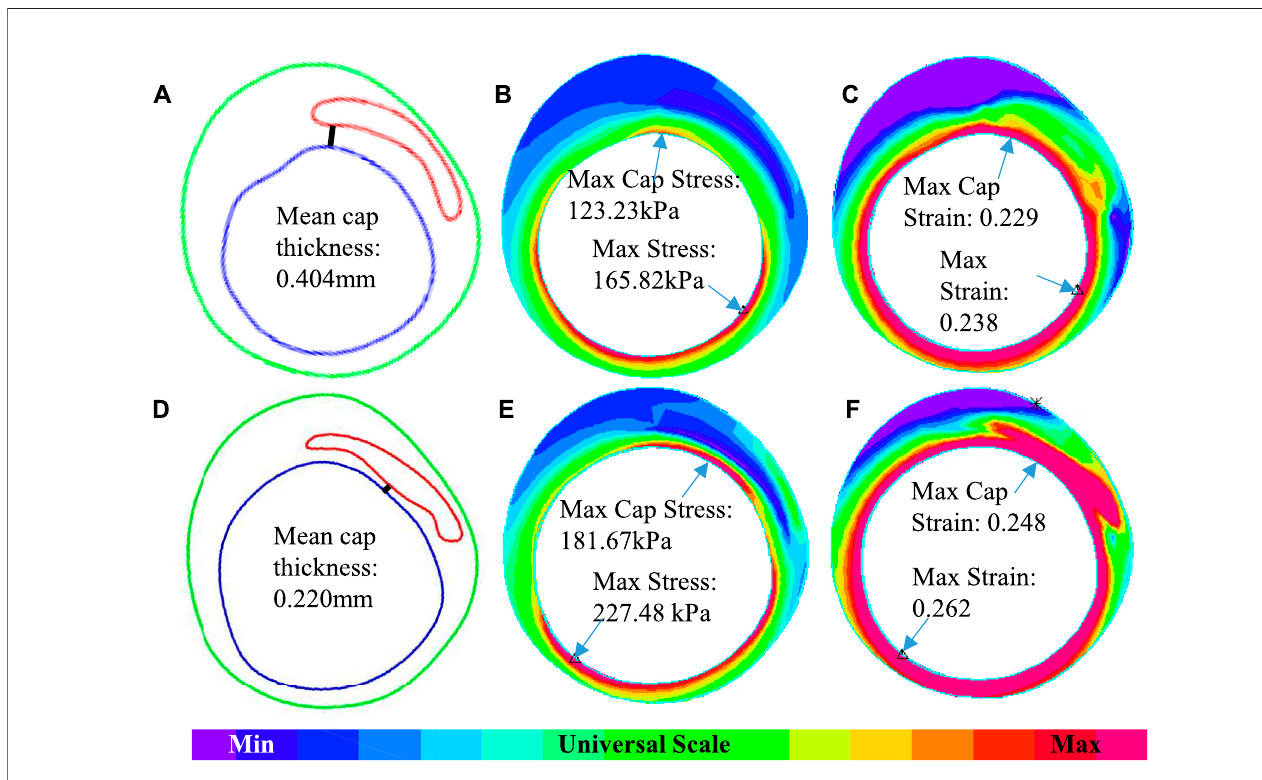
FIGURE4| Anexampleshowingthedifferencesofcapthickness,maximumcapstress,andmaximumcapstraininthecapregionandmaximumstressandstrain on the whole lumen for IVUS + OCT (IO) and IVUS. (A – C) IO slice — contour, stress, and strain plots. (D – F) IVUS slice — contour, stress, and strain plots.